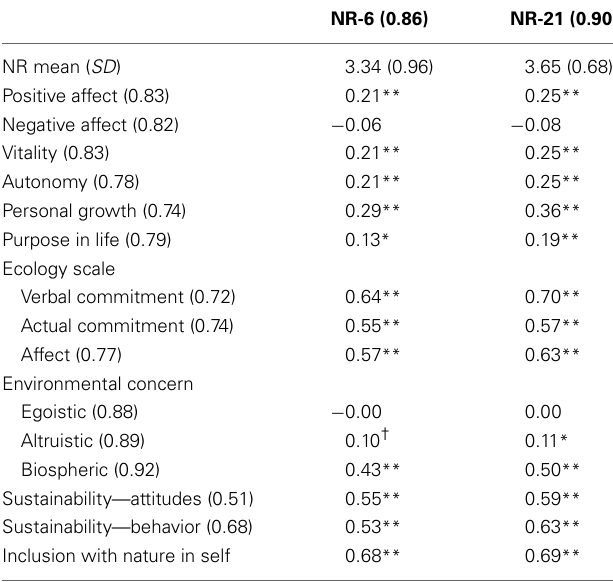
Table 3 | Study 3—nature relatedness correlations with well-being and environmental measures in students ( N =